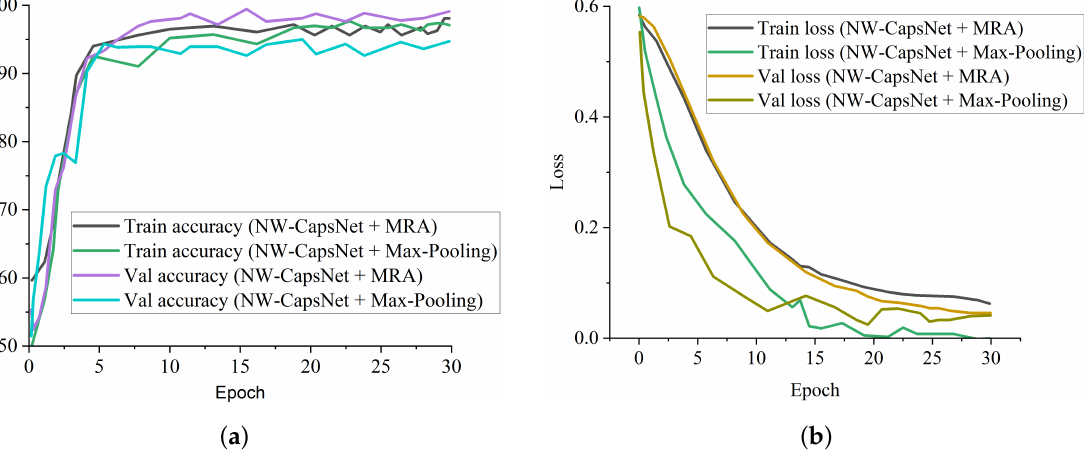
Figure 5. Training and validation curves for the proposed model with different down-sampling operations. ( a ) Accuracy curves showing the influence of the choice of down-sampling operation on the overall performance of the model. ( b ) The loss curves for our proposed model showing the influence of the choice of down-sampling operation.